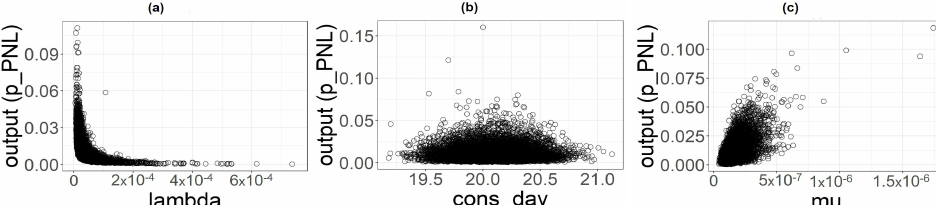
Figure 7. Scatterplot of input parameters for category PNL versus the output considered ( p PNL ). ( a ) λ PNL . ( b ) cons PNL ( c ) µ . day